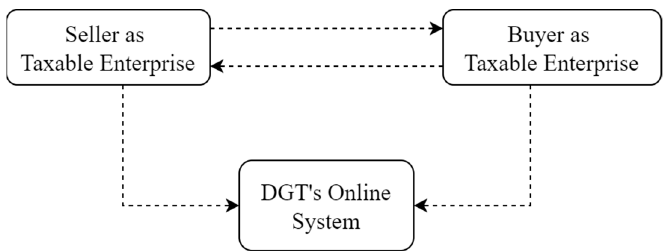
Figure 2. Buyer and seller position scheme in the Indonesian VAT system.